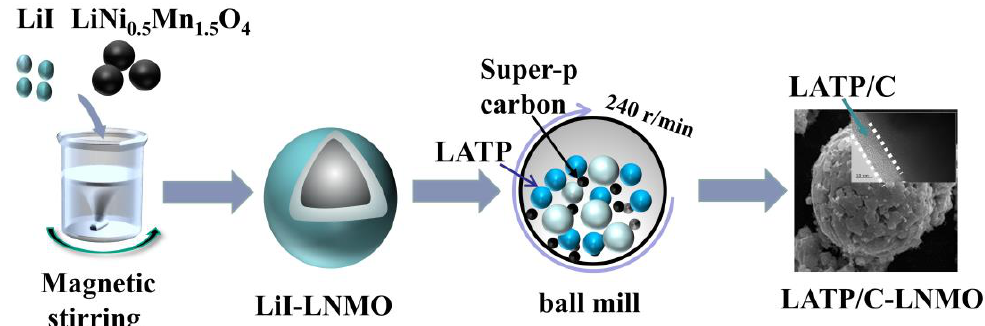
Figure 1. The schematic diagram of LATP/C coated LNMO composites materials.